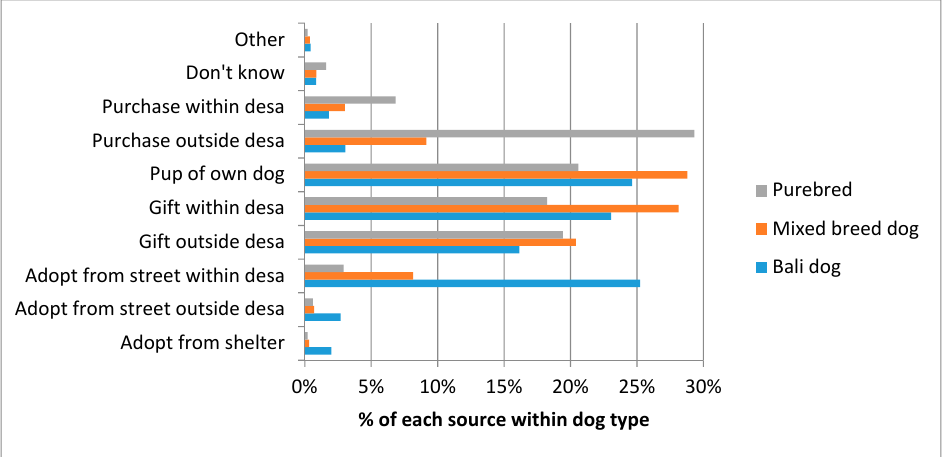
Figure 1. Source of dogs, broken down by dog breed type.